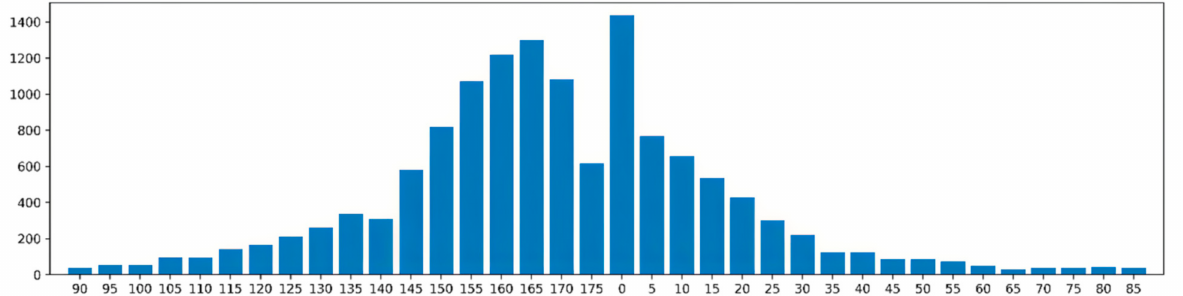
Figure 2. Analysis of crucian carp dataset. The angle distribution histogram in Figure 2 can be regarded as a normal distribution diagram on the whole, which counts the amount of grass gold at various angles, reflecting the randomness of the